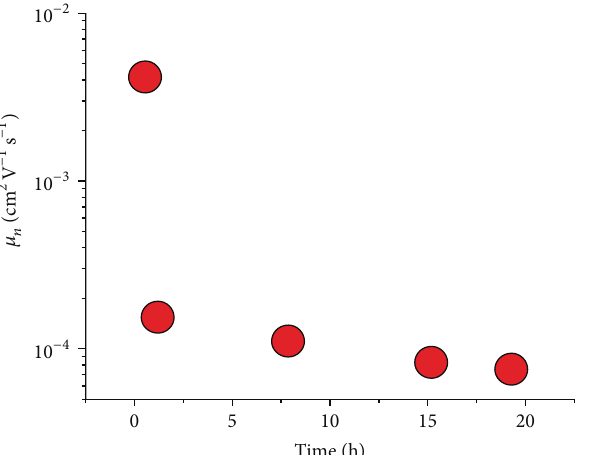
Figure 4: Variation of the carriers mobility in P3HT films as a function of exposure time to the